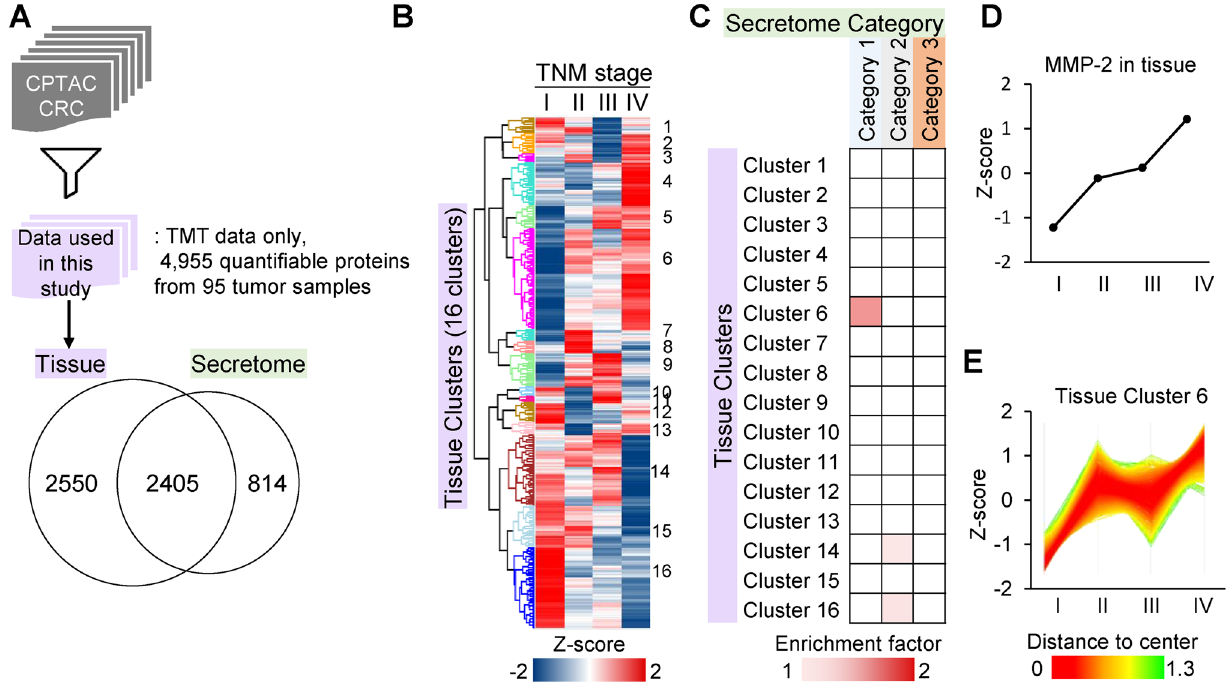
Figure 4. Comparative analysis of the cell secretome with the tissue proteome of CRC cancer patients. ( A ) Schematic workflow of tissue proteome analysis. The tissue proteomic data were obtained from a public data repository shared by CPTAC. The numbers in the Venn diagram represent overlap between identified proteins from the HCT116 secretome and the tissue proteome. ( B ) Unsupervised hierarchical cluster analysis of CRC tissue proteins according to CRC stage. ( C ) Fisher’s exact test between the three secretome categories and 16 tissue clusters (Benjamini–Hochberg FDR < 0.02). The color intensity represents the enrichment factor of the association between the secretome and tissue clusters. ( D ) Z-scored expression profile of MMP-2 in the tissue proteome relative to CRC stage. ( E ) Z-scored expression profiles of the proteins in the tissue cluster